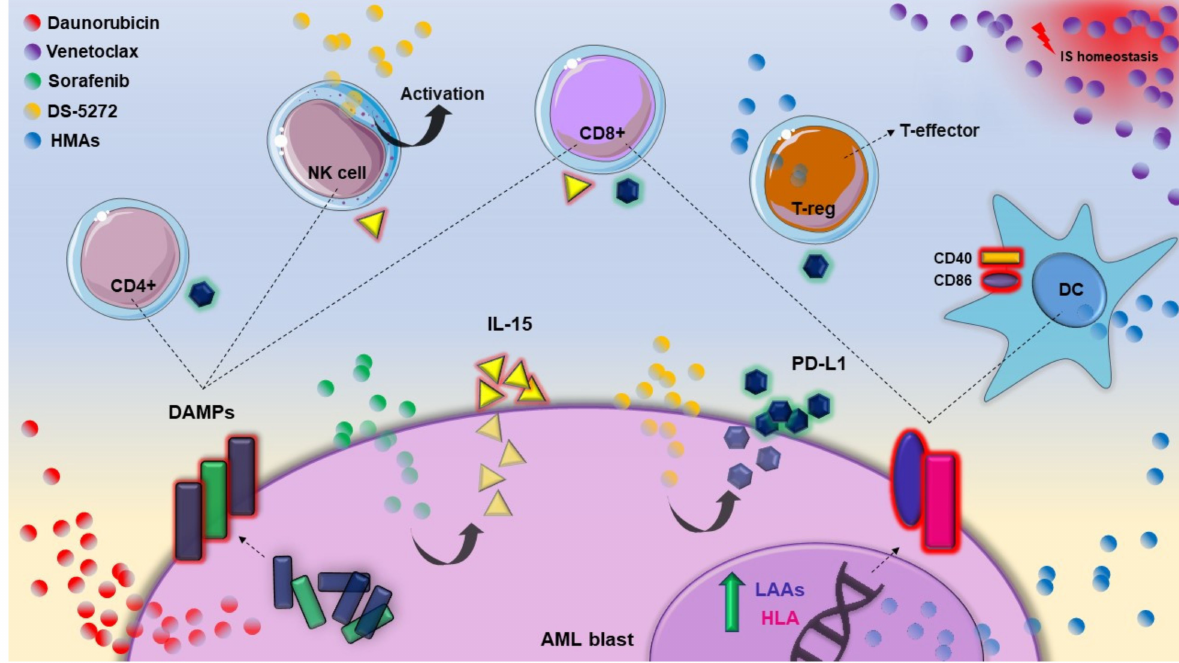
Figure 1. Crosstalk between the leukemic cell and its immunologic counterpart. The main molecular effects of the drugs used for AML treatment. From left to right: daunorubicin induces IS-mediated neoplastic cell death through the translocation of DAMPs on the cell surface. Sorafenib activates CD8+ T-lymphocytes and NKs by restoring the blast production of IL-15. DS-5272 activates NKs and triggers an immunoinflammatory response through PD-L1 overexpression. HMAs increase the T-cell recognition of leukemic cells through the overexpression of LAAs and HLA, activate DCs through the overproduction of CD40 and CD86 and promote a T-reg shift to a T-effector. Venetoclax impairs the IS